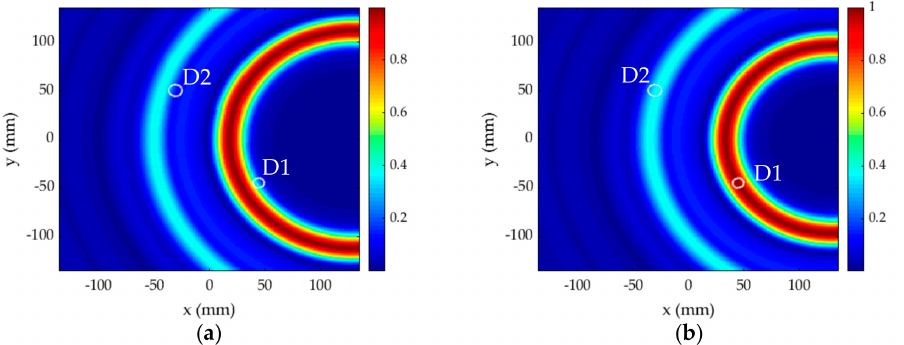
Figure 18. Possibilities of damage existence in multiple damage scenario for sensing path A8B8: ( a ) without time compensation; ( b ) with time compensation.